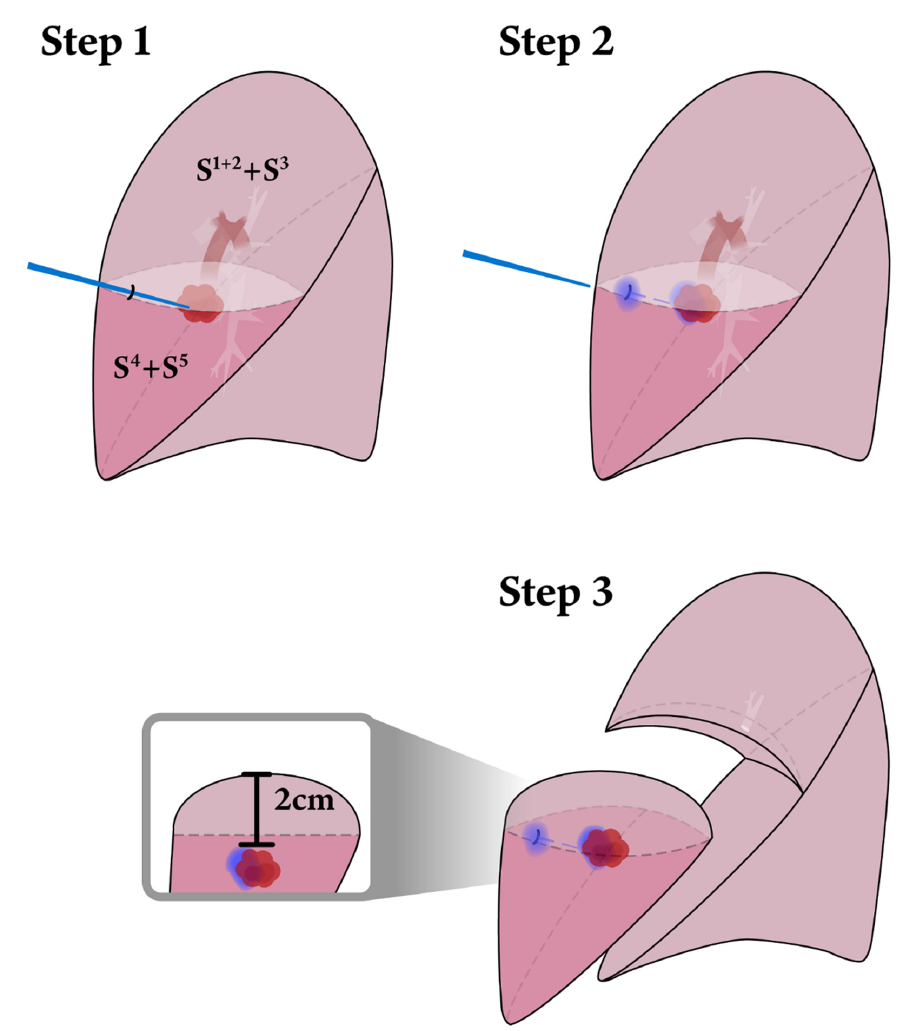
Figure 2. Operative procedures. Step 1 and 2 : The blue line indicates the CT-guided dye localization located above the lesion. Step 3 : With the help of the dye, segmentectomy can be performed with an extra margin for lesions over the intersegmental plane.